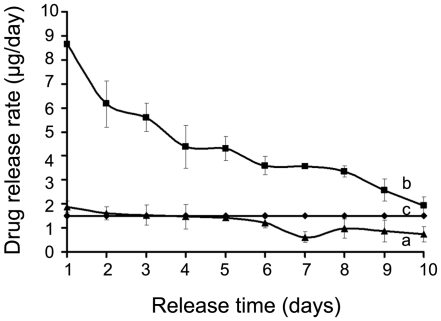
Latanoprost release rate from 100 µl of DPPC LUVs with two different drug/lipid mole ratios compared with 1 drop of commercial Xalatan® solution (1.5 µg/drop).In vitro drug release rate (µg/day) measured from (a) drug/lipid, 0.04 and (b) drug/lipid, 0.11, (c) commercial eye drop (Xalatan®, 1.5 µg/drop). The release rates are reported based on mean values of at least two batches and standard deviations are reported in error bars.